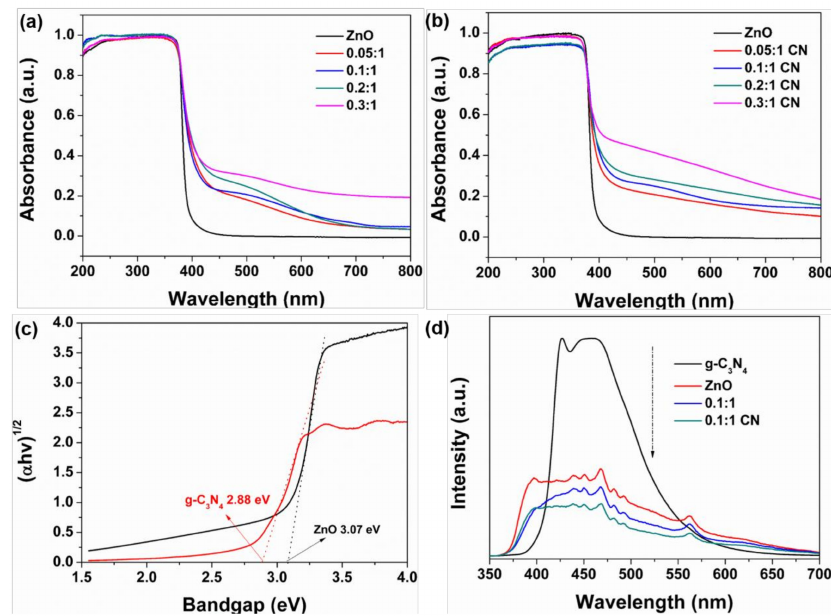
Figure 5. ( a , b ) UV–VIS diffuse reflectance spectroscopy (DRS) spectra for ZnO and the g-C 3 N 4 /ZnO samples, ( c ) the plots of ( α hv) 1/2 versus bandgap of ZnO nanorods and g-C 3 N 4 , ( d ) photoluminescence (PL) spectra of the prepared photocatalysts.